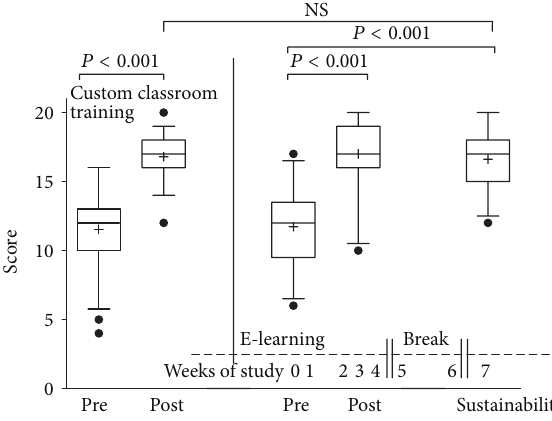
Figure 3: Comparison of two learning strategies: e-Learning